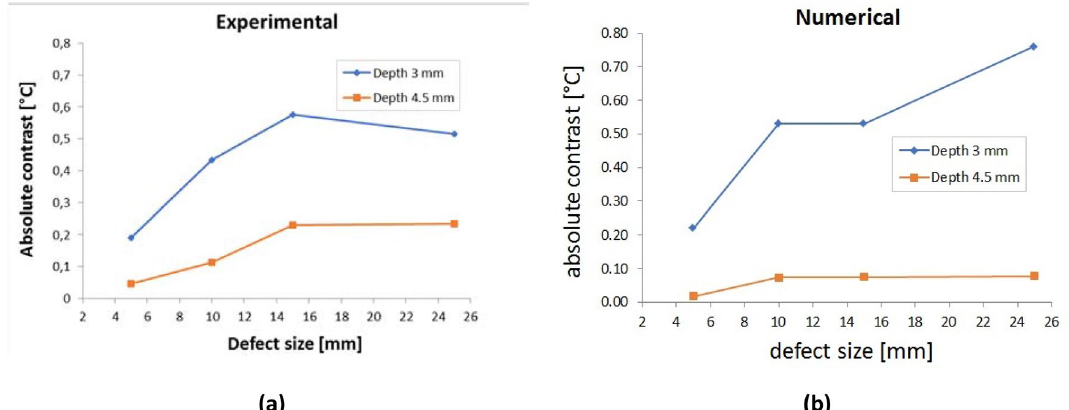
Fig. 17 Absolute contrasts vs defect size for experimental ( a ) and numerical ( b ) traditional thermography